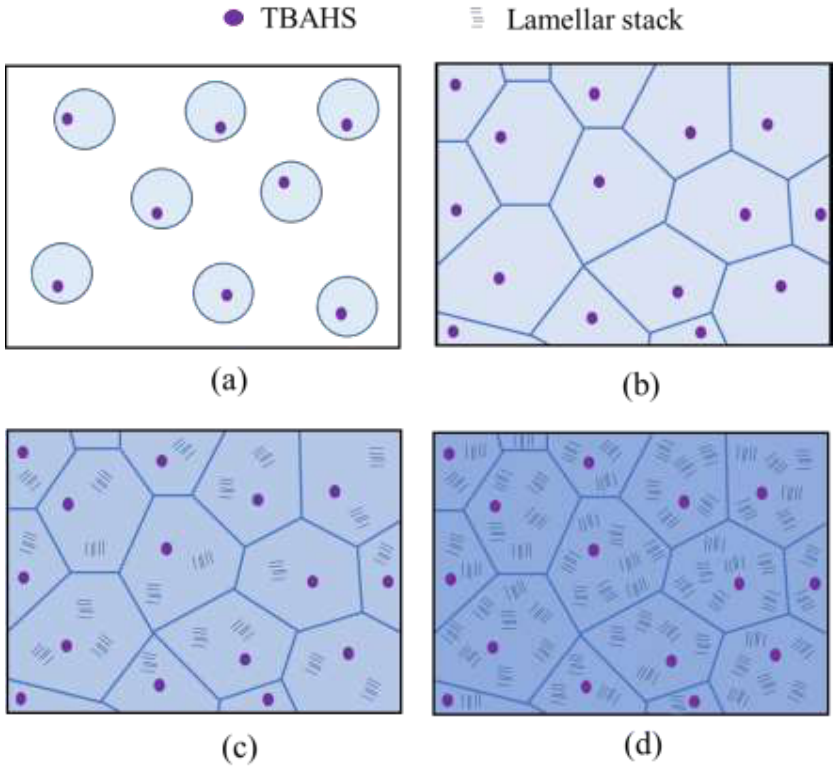
Figure 10. Schematic illustrations of the development of γ -spherulite of PVDF/TBAHS during isothermal crystallization at 165 ◦ C: ( a ) 4 min, ( b ) 10 min, ( c ) 15 min, and ( d ) 20 min.